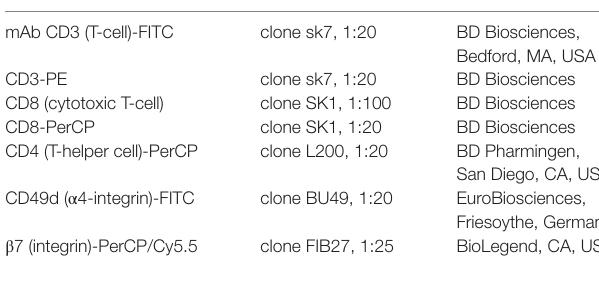
TaBle 1 | Patient characteristics. TaBle 2 | Antibodies for FACS